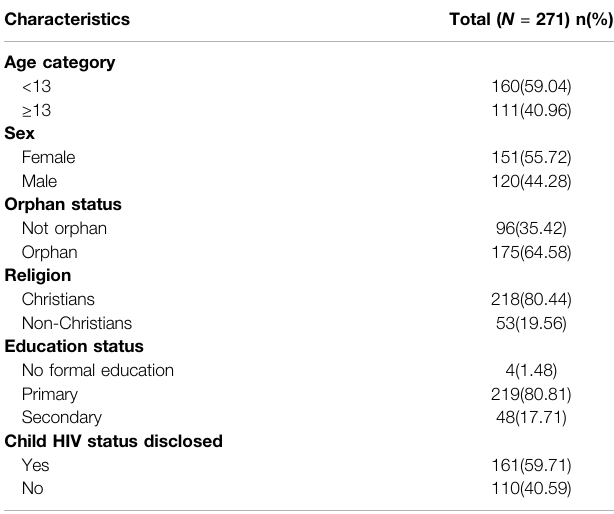
TABLE 1 | Socio-demographics characteristics of the study participants ( N (cid:1) 271).